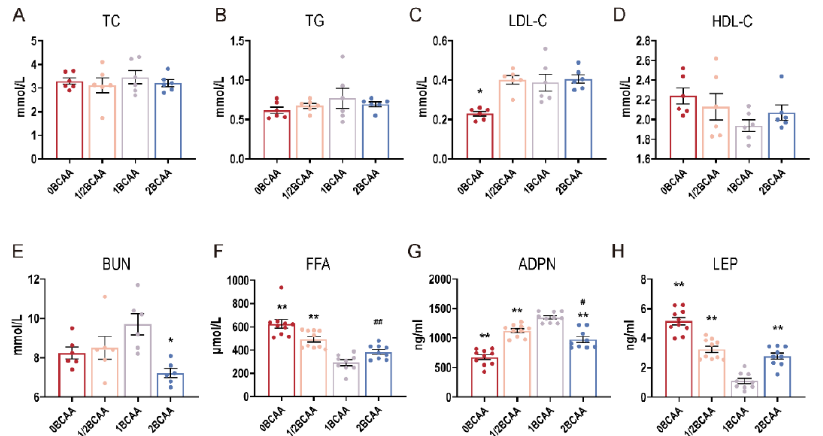
Figure 3. Effects of different dietary BCAA levels on serum biochemical indices in lean mice. ( A ): Total cholesterol; ( B ): Total triglycerides; ( C ): Low-density lipoprotein cholesterol; ( D ): High-den- sity lipoprotein cholesterol; ( E ): Urea nitrogen; ( F ): Free fatty acid; ( G ): Adiponectin; ( H ): Leptin. Values are presented as the means ± SEM. ( A – E ): n = 6; ( F – H ): n = 10. TC: Total cholesterol; TG: Total triglycerides; LDL-C: Low-density lipoprotein cholesterol; HDL-C: High-density lipoprotein cho- lesterol; BUN: Urea nitrogen; FFA: Free fatty acid; ADPN: Adiponectin; LEP: Leptin. * p < 0.05, ** p < 0.01 versus 1BCAA group. # p < 0.05, ## p < 0.01 in 2BCAA group versus 1/2BCAA